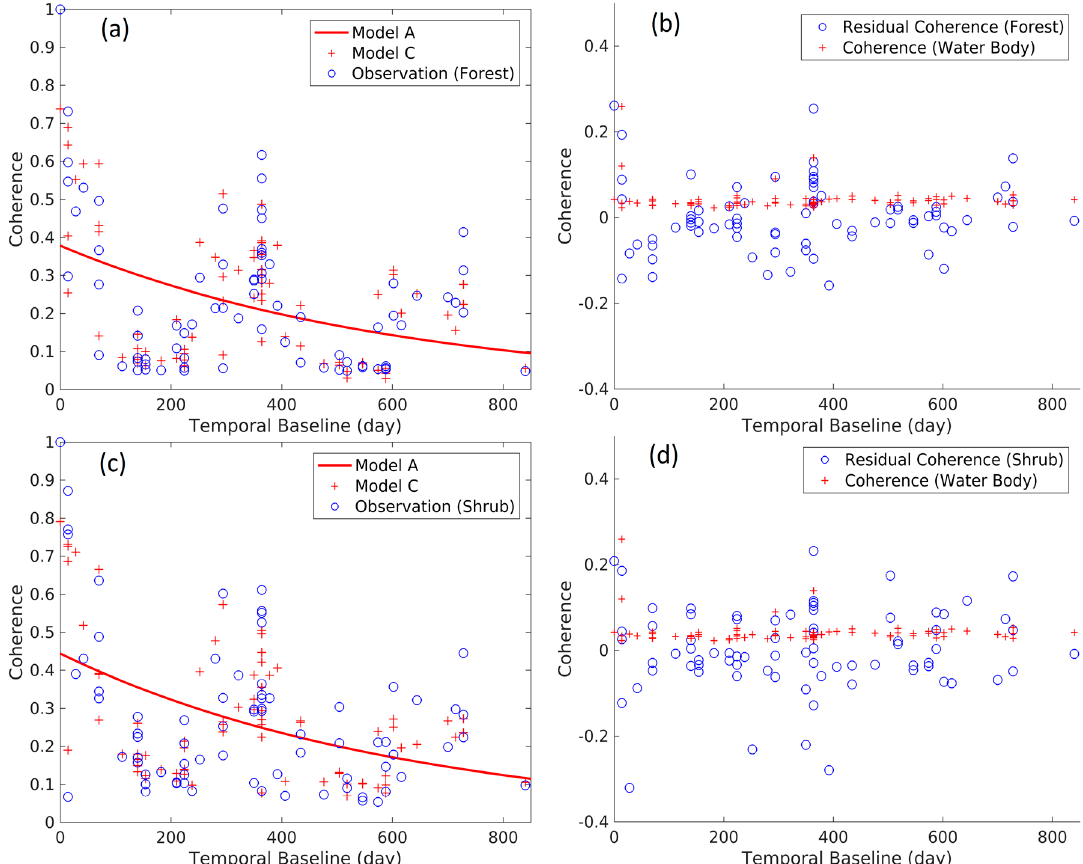
Figure 6. Semi-logarithmic scatter plot of the coherence ratio, i.e., observation/model B, versus snow depth changes (meter) for forested ( a ) and shrub ( b ) land cover types.